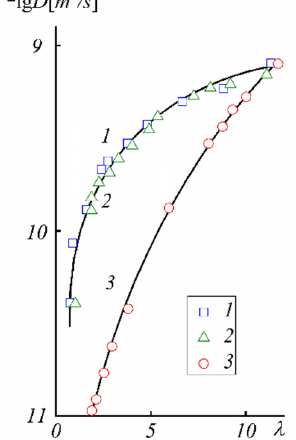
Figure 6. Humidity dependences of the water self-diffusion coefficients in the acid ionic form of the sulfo cation exchanger CU-2-8 (Russian analog of Dowex 50 W). 1, 2, calculated from Equation (1); 3, measured by PFG NMR. 1, sample swelled in H 2 O; 2, sample swelled in D 2 O, signal of residual protons was recorded (adapted from